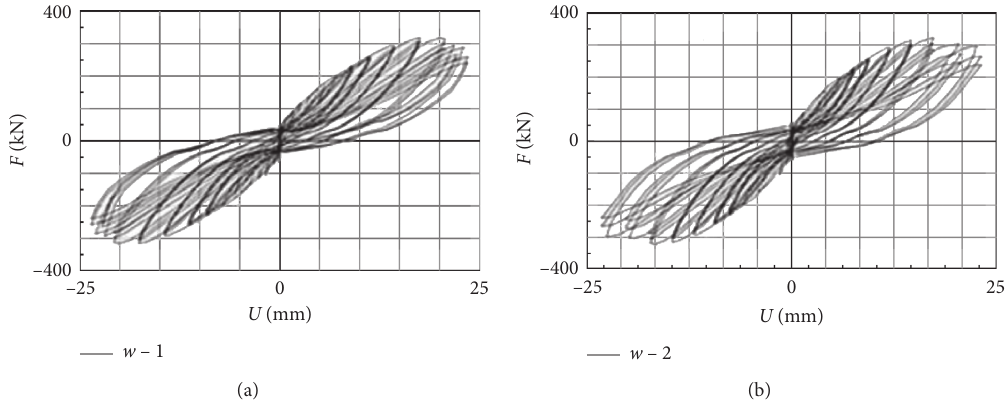
Figure 10: Hysteresis diagram of the reinforced concrete panel with a bracing.